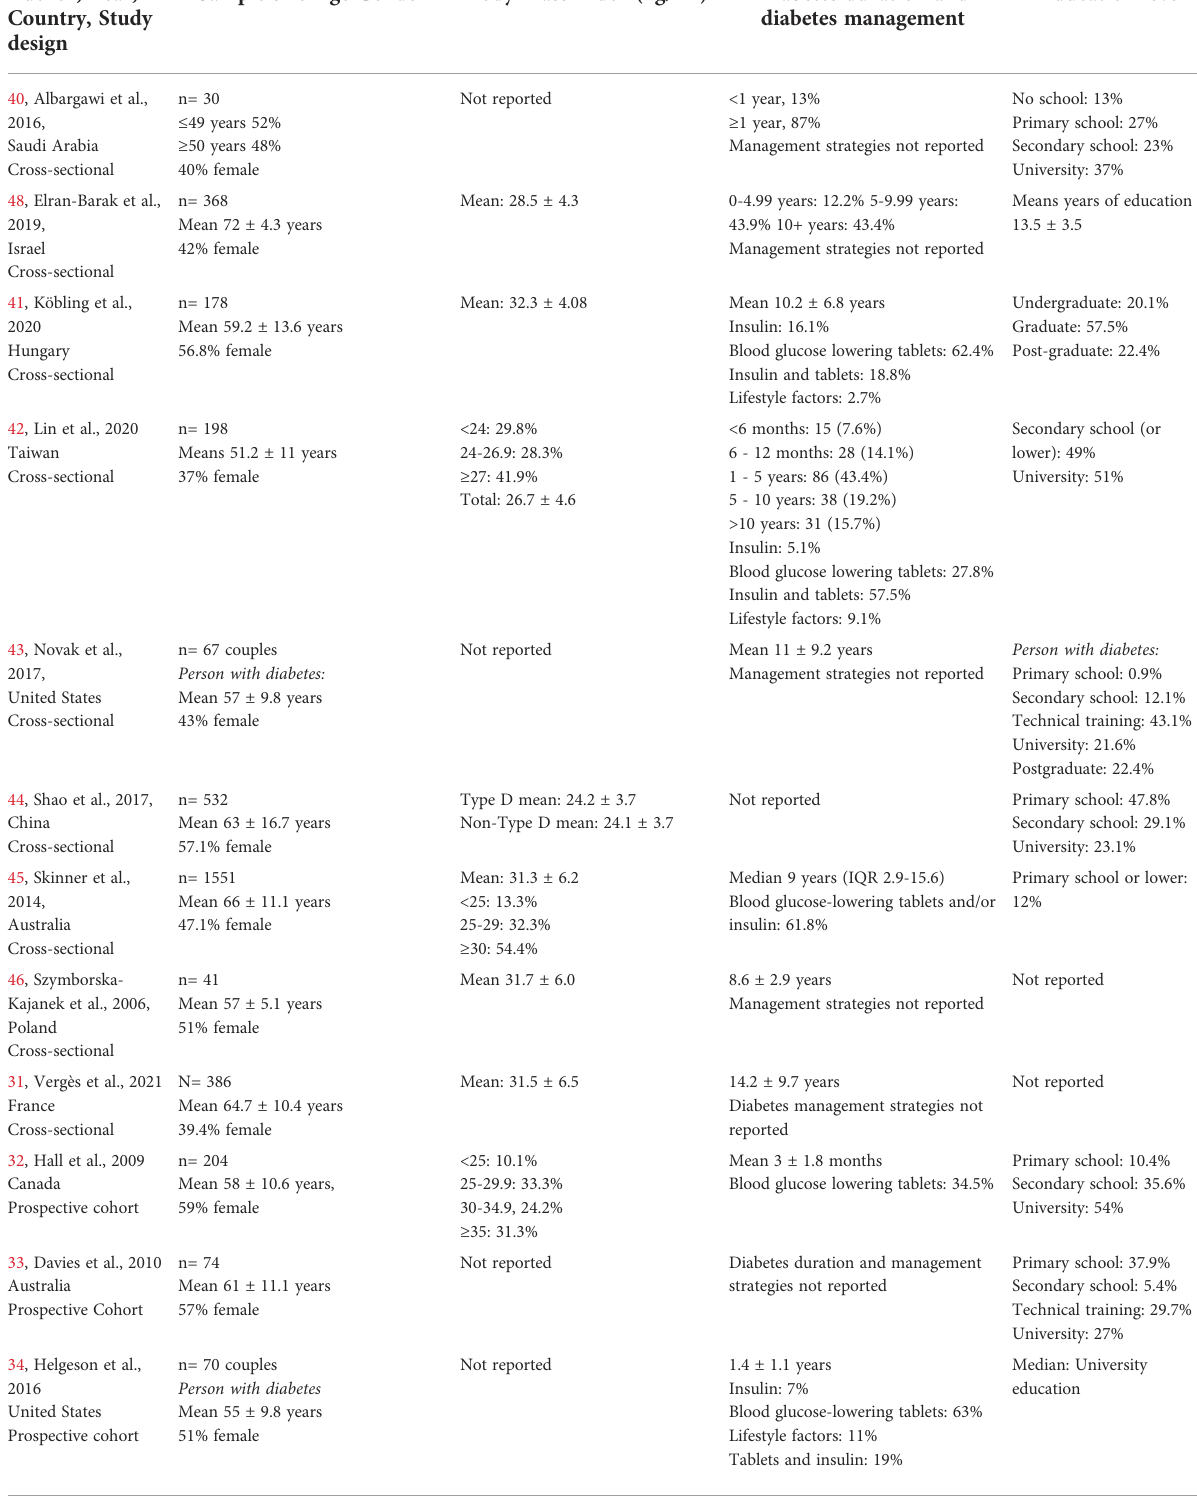
TABLE 1 Participants ’ clinical and demographic characteristics, by study